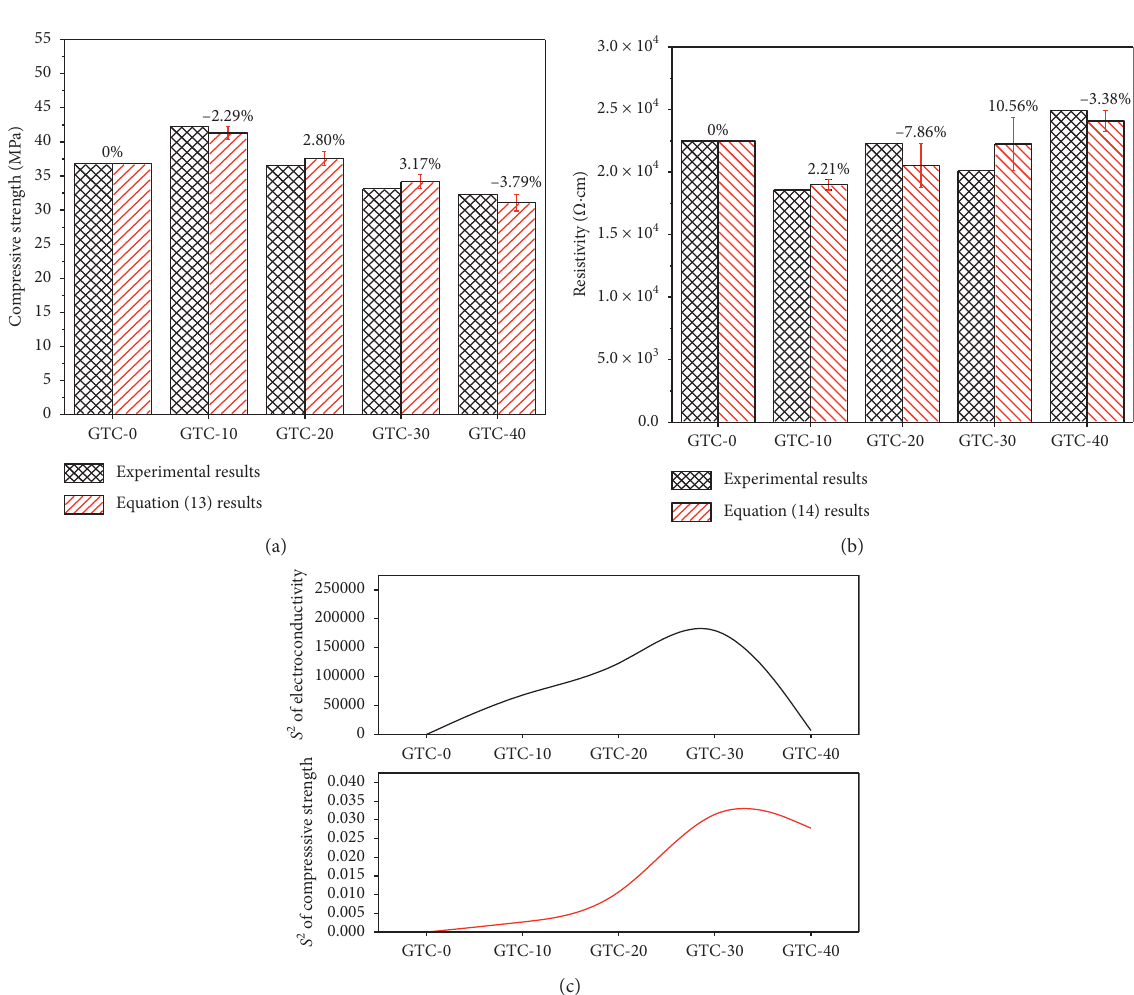
Figure 16: Calculation error and comparison on mechanical and resistivity properties of GTC (0% to 40%). (a) Compressive strength; (b) resistivity; (c) variance.